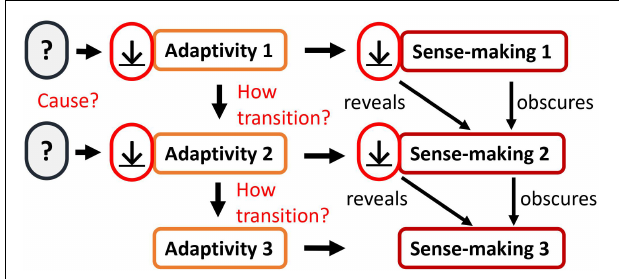
FIGURE 3 | The main gaps of the “stage 1” approach as it is outlined in Figure 2 : (1) What causes the respective adaptivity act to decrease? (2) How does the cognitive system transition from decreasing one act of adaptivity to decreasing another subtler act of adaptivity?